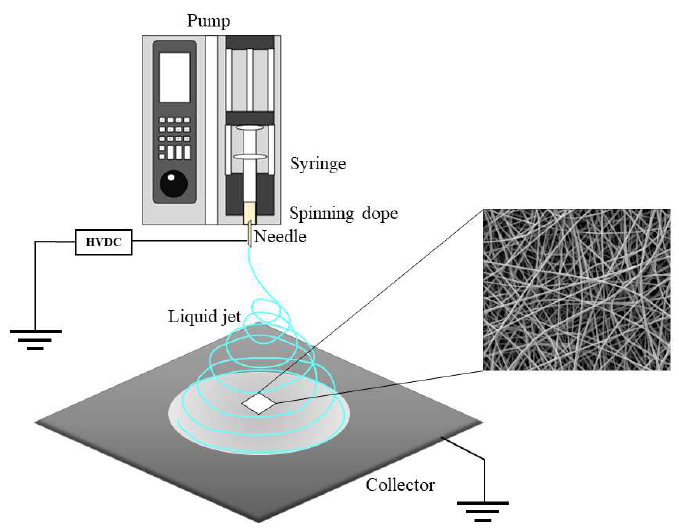
Figure 9. Schematic representation of the electrospinning process. HVDC, high-voltage direct cur- rent.